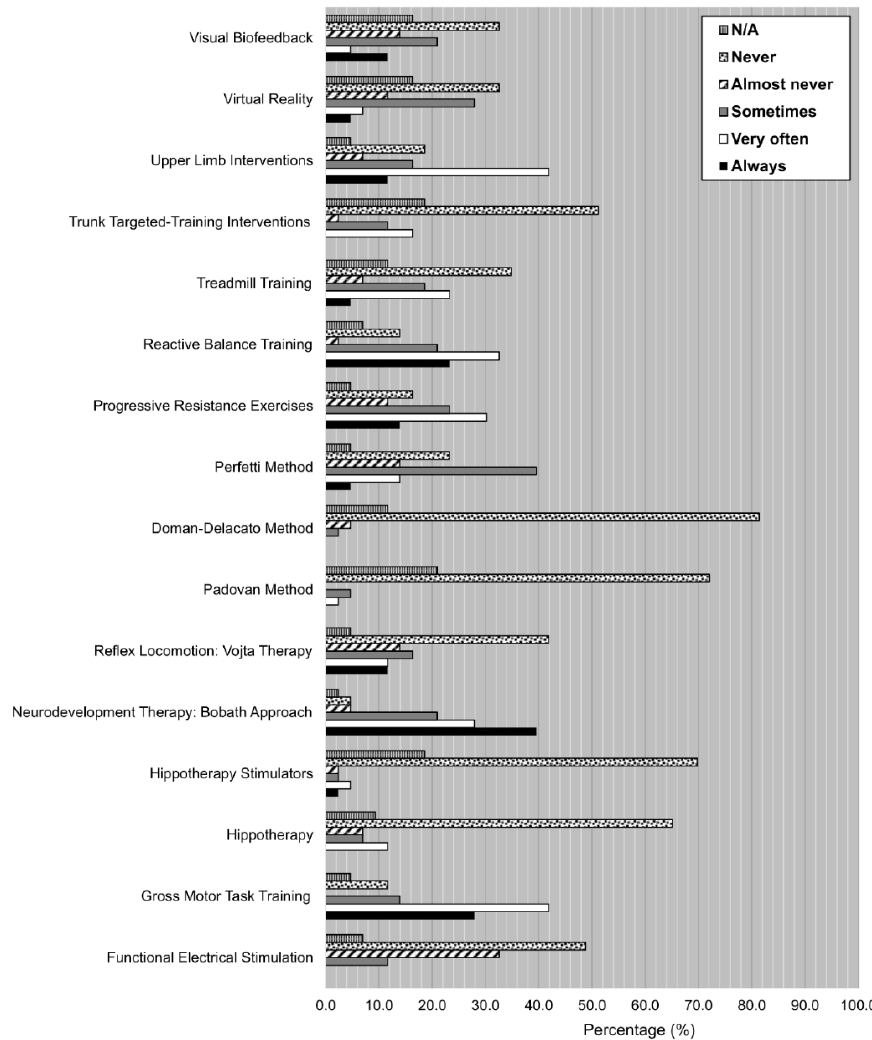
Figure 2. Degree of use (%) for each one of the techniques, therapies and interventions listed on the survey. Scale: always, very often, sometimes, almost never, never, N/A.